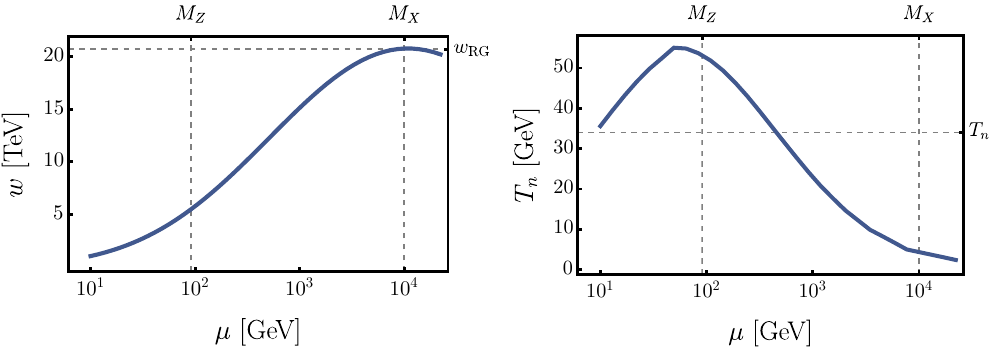
Figure 19 . RG scale dependence of the location of the minimum in the ϕ direction (left panel) and of the nucleation temperature (right panel). Vertical lines indicate characteristic energy scales, while horizontal the values of w and T , respectively, computed using the RG-improved n